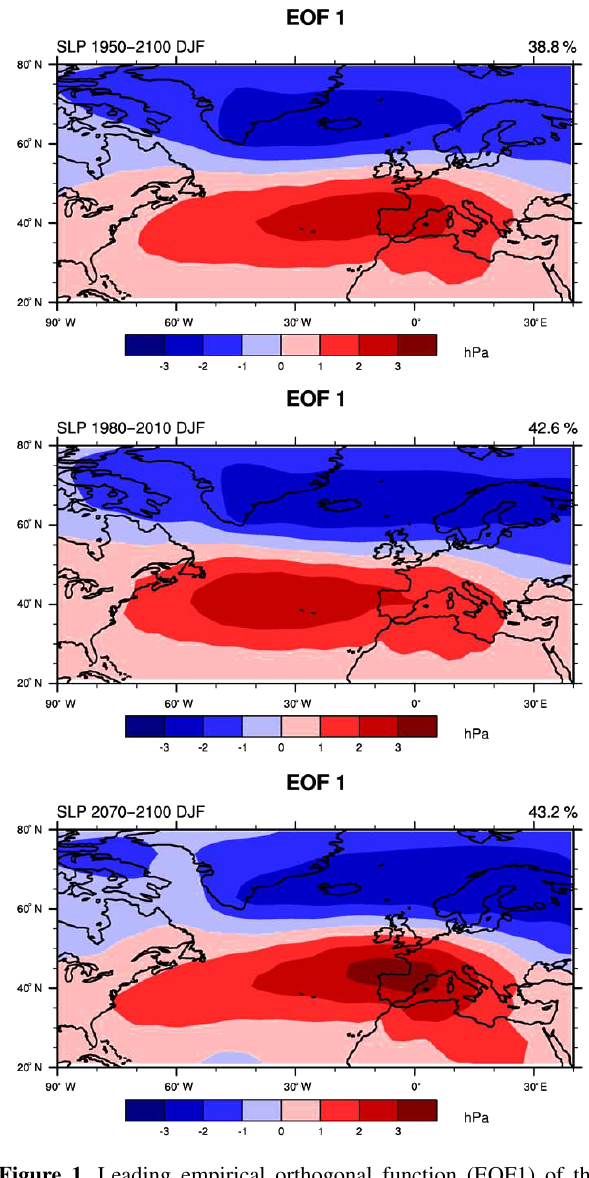
Figure 1. Leading empirical orthogonal function (EOF1) of the winter (DJF) mean sea-level pressure (SLP) anomalies in the North Atlantic sector (20–80 ◦ N, 90 ◦ W–40 ◦ E) of the coupled simulation considering the full period 1950–2100 (top), recent past period: 1980–2010 (centre), and future period: 2070–2100 (bottom). The percentage at the top right of each figure quantifies the total vari- ance explained. The patterns are displayed in terms of amplitude (hPa), obtained by regressing the SLP anomalies on the principal component time